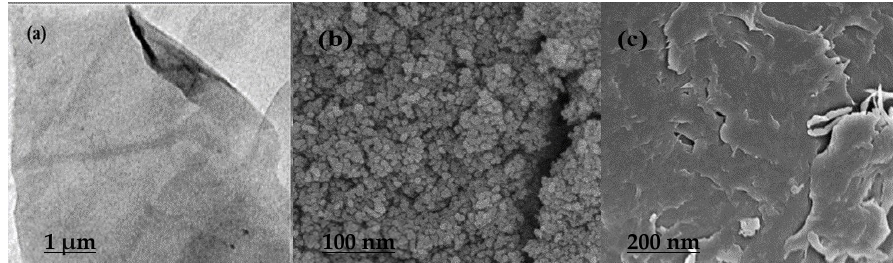
Figure 2. TEM and FESEM micrograph of GO and MGO: ( a ) TEM of GO, ( b ) TEM of MGO, and ( c ) FESEM of MGO.